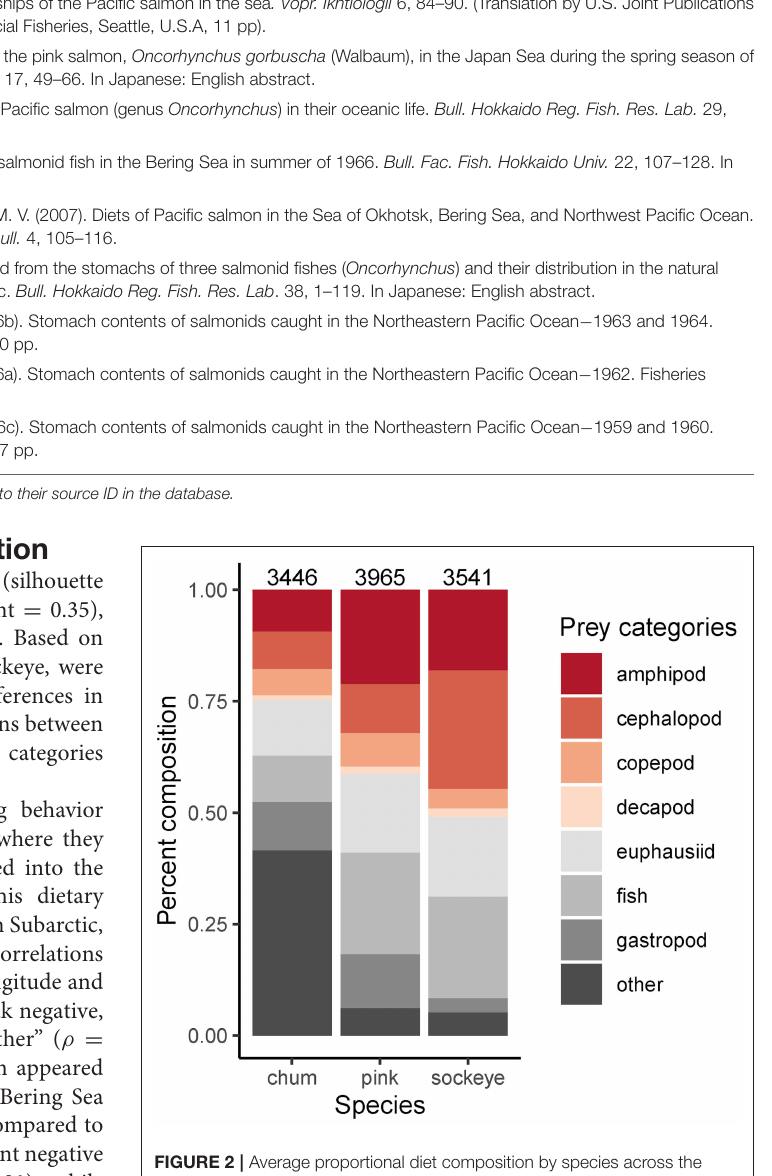
a weaker, but still significant, negative correlation with latitude ( ρ = − 0.141, p =